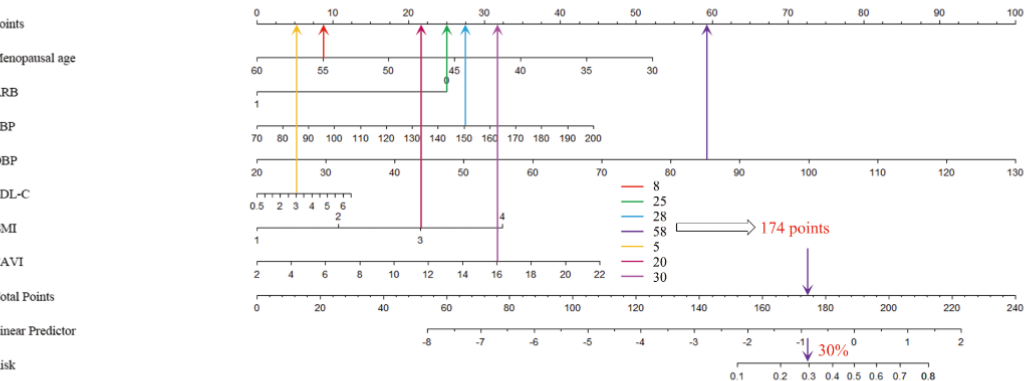
Figure 3. Case: a 55-year-old menopausal patient with hypertension (8 points) who did not take ARB drugs (25 points) had an early morning systolic blood pressure of 150 mmHg (28 points), diastolic blood pressure of 85 mmHg (58 points), LDL-C of 3 mmol/L (5 points), BMI greater than 24 kg/m 2 (20 points), CAVI of 16 (30 points), corresponding total score of 174 points, and the predicted risk value of the nomogram was about 30%. ARB: angiotensin receptor blocker; BMI: body mass index; CAVI: cardio-ankle vascular index; DBP: diastolic blood pressure; SBP: systolic blood pressure; LDL-C: low-density lipoprotein